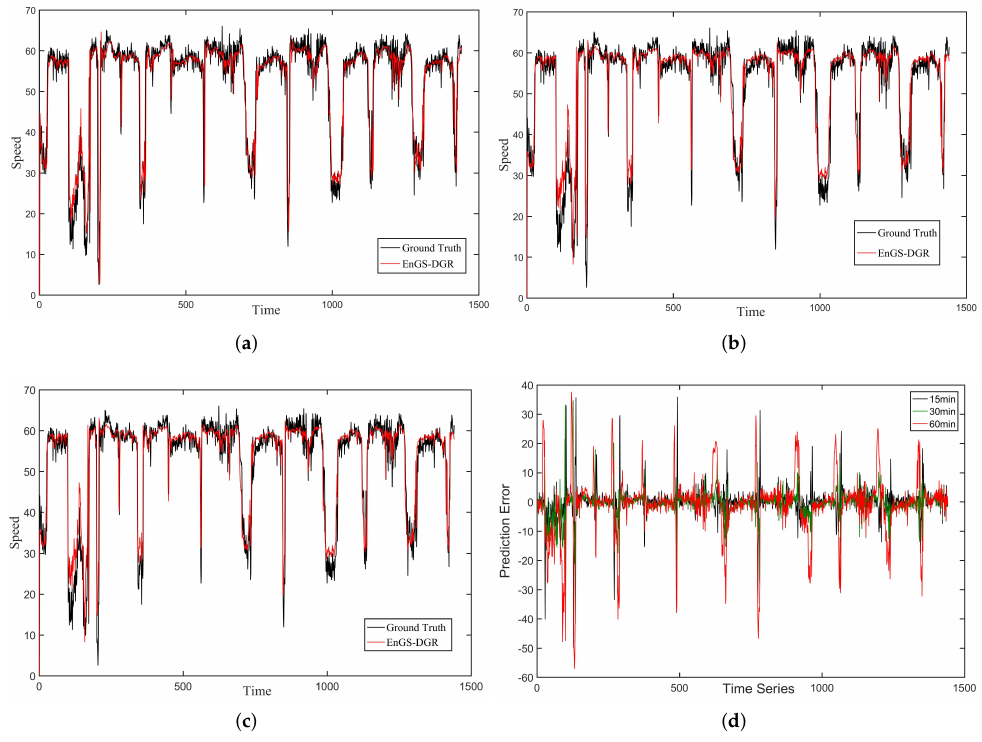
Figure 7. Visualization of forecast results for METR-LA dataset. ( a ) The comparison curves under 15 min forecasting interval. ( b ) The comparison curves under 30 min forecasting interval. ( c ) The comparison curves under 60 min forecasting interval. ( d ) The curves of forecasting